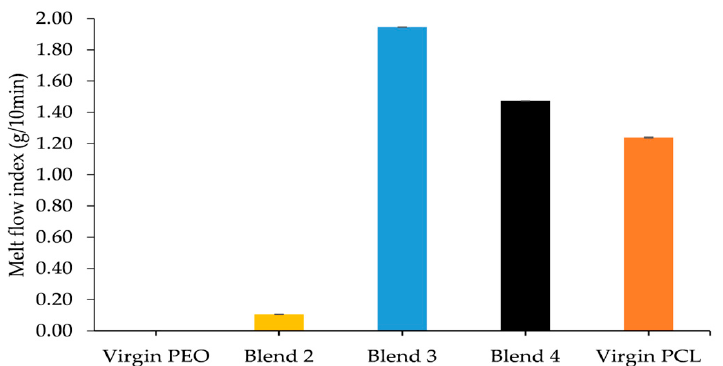
Figure 2. Melt flow index results of monolithic batches.